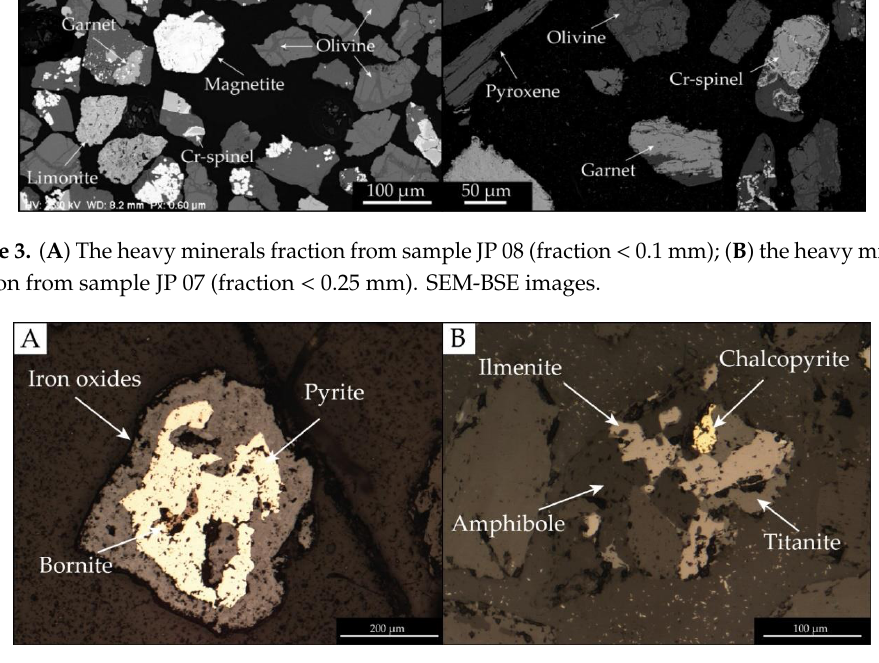
Figure 4. Sulphides in the Central Unit sediments. Sample JP36. ( A ) Pyrite dispersed in iron oxides; ( B ) chalcopyrite within amphibolite. Replacement of ilmenite with titanite. Reflected-light microscopy images. Magnification ×5.